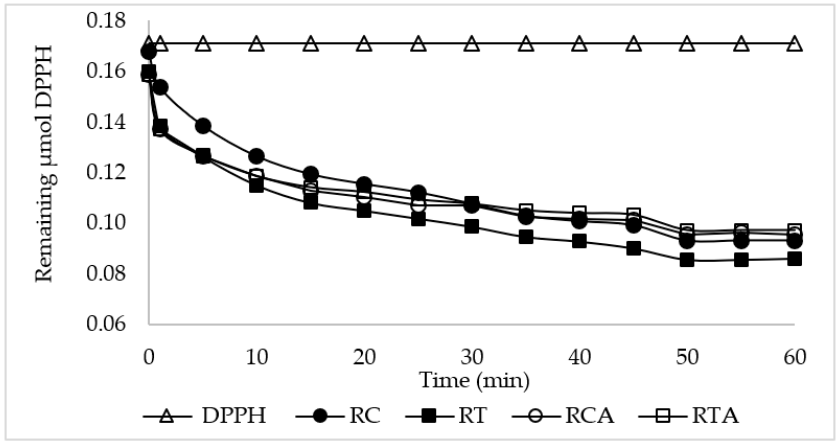
Figure 2. Time evolution of the DPPH curves in methanol of organic extracts from FB samples.